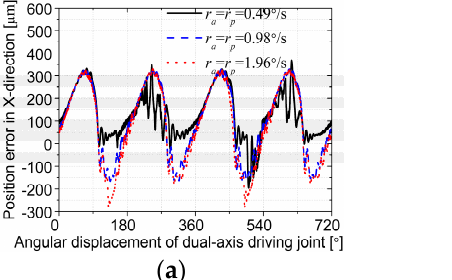
change in X-direction; ( b ) component change in Y-direction; and ( c ) component change in Z-direction.